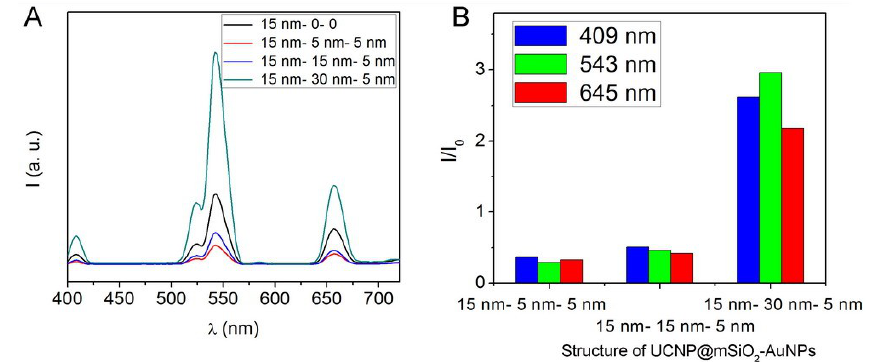
Figure 7. ( A ) Experimental UCL spectra I ( λ ) of UCNP@mSiO 2 -Au NPs with different structure and ( B ) the corresponding enhancement factor I / I 0 corresponding to the intensity maxima at the different emission regions. I 0 refers to the intensity of the plain UCNPs (geometry 15 nm–0–0).